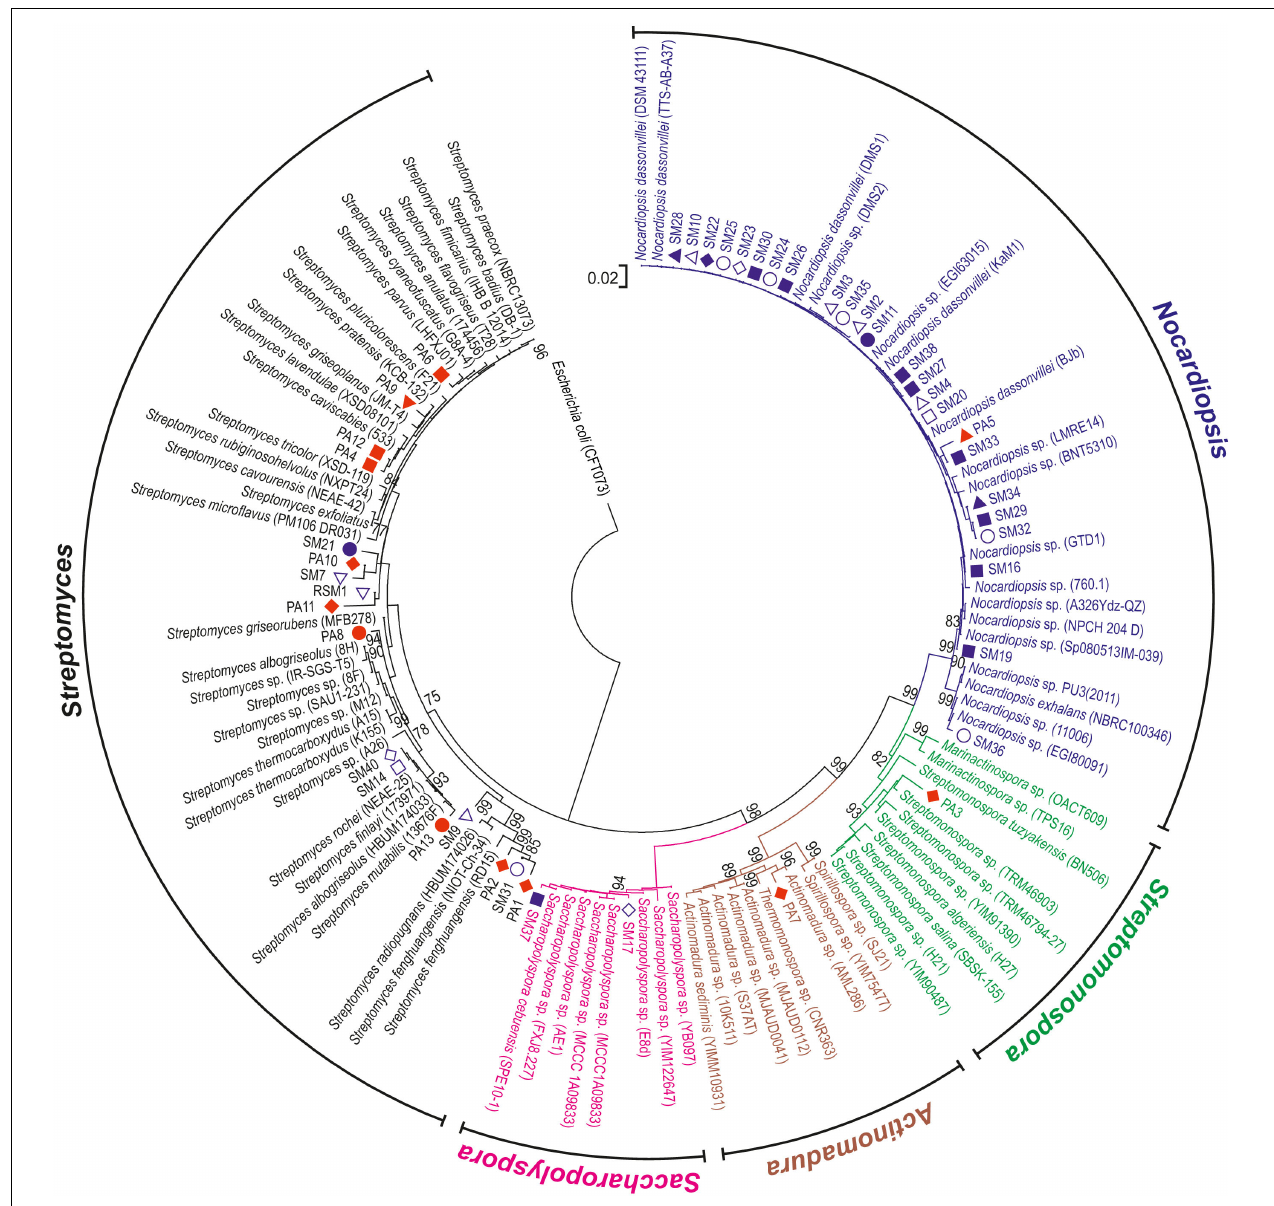
FIGURE 3 | Phylogenetic analysis of actinomycete isolates. The phylogenetic tree was constructed from 16S rRNA gene sequences from sponge isolates together with type strain sequences obtained from sequence databases. The tree was rooted using the sequence from E. coli as an outgroup. Bootstrap values greater than 75% are shown at the nodes and are based on 1000 replicates. Scale bar indicates 0.02 substitutions per nucleotide. The red and blue symbols adjacent to the analyzed bacterial strains correspond to sponge host ( Figure 1 ).